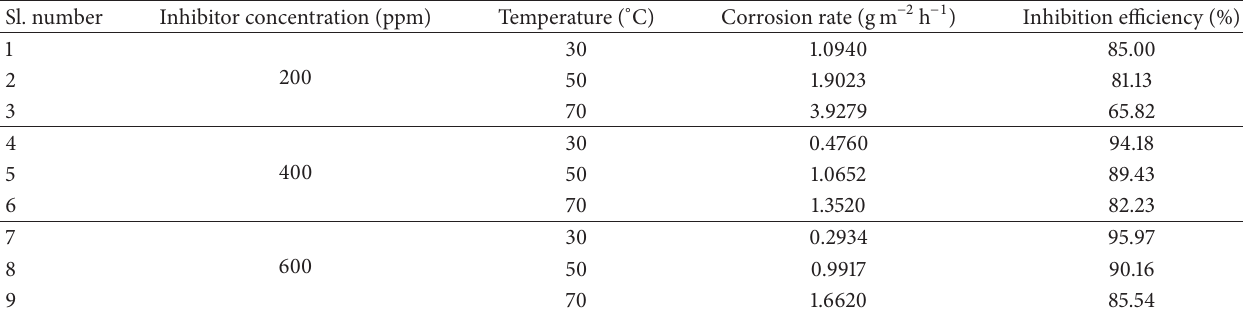
Table 1: Inhibition efficiency and corrosion rate data of mild steel in 1M NaOH in the absence and presence of inhibitor in different temper- ature and